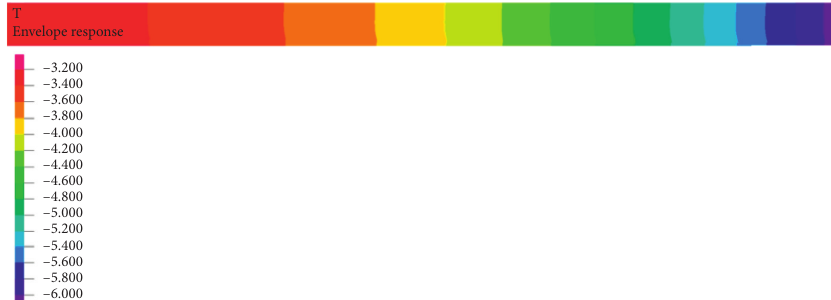
Figure 17: Annual average air temperature distribution in the tunnel axis with a thermal conductivity of 0.02W/(m · ° C).